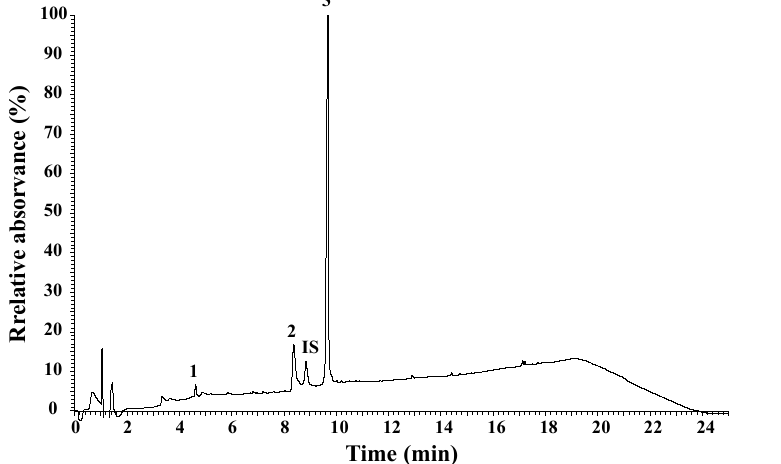
Figure 2. Chromatographic pro fi le of Morocco bee venom: 1—apamin; 2—phospholipase A2 (PLA2); 3—meli tt in; IS—internal standard (cytochrome c, 25 µg/mL).